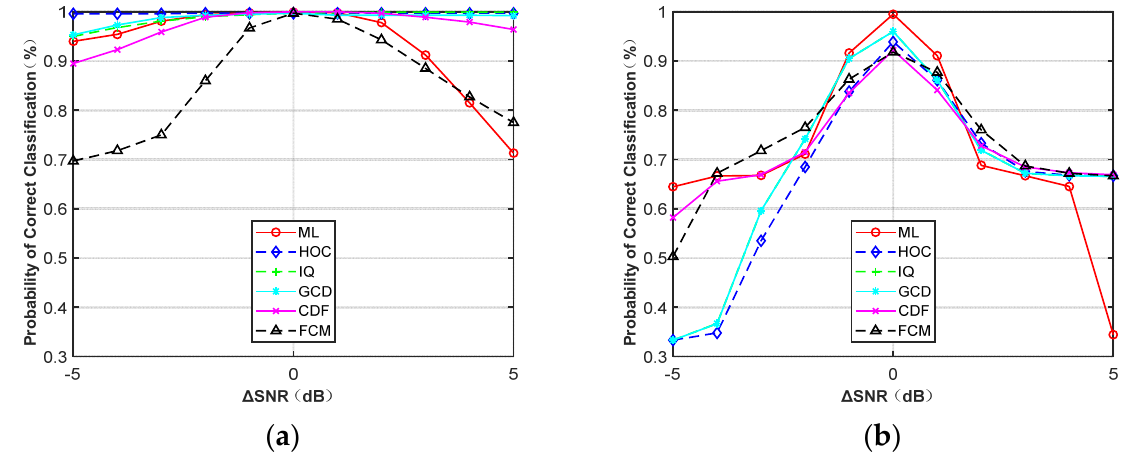
Figure 11. Probability of correct classification versus SNR errors. ( a ) MPSK (SNR = 6, N = 128). ( b ) MQAM (SNR = 10, N = 512).